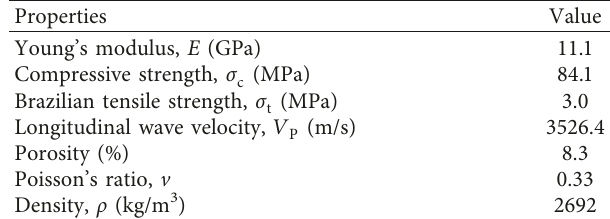
Table 1: Physical and mechanical properties of the tested fine sandstone.